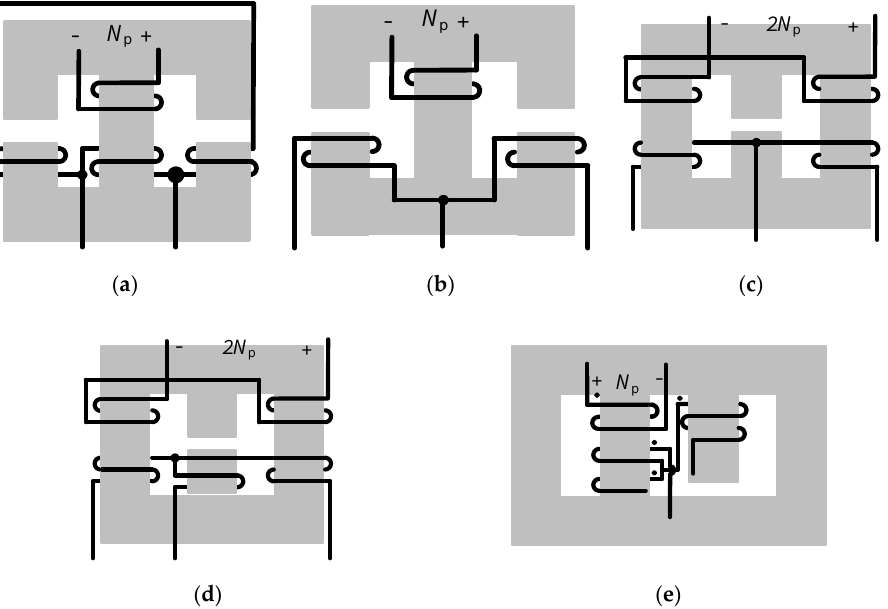
Figure 1. Structures and winding layout of five integrated magnetic components: ( a ) structure I, ( b ) structure II, ( c ) structure III, ( d ) structure IV, and ( e ) structure I–IV.